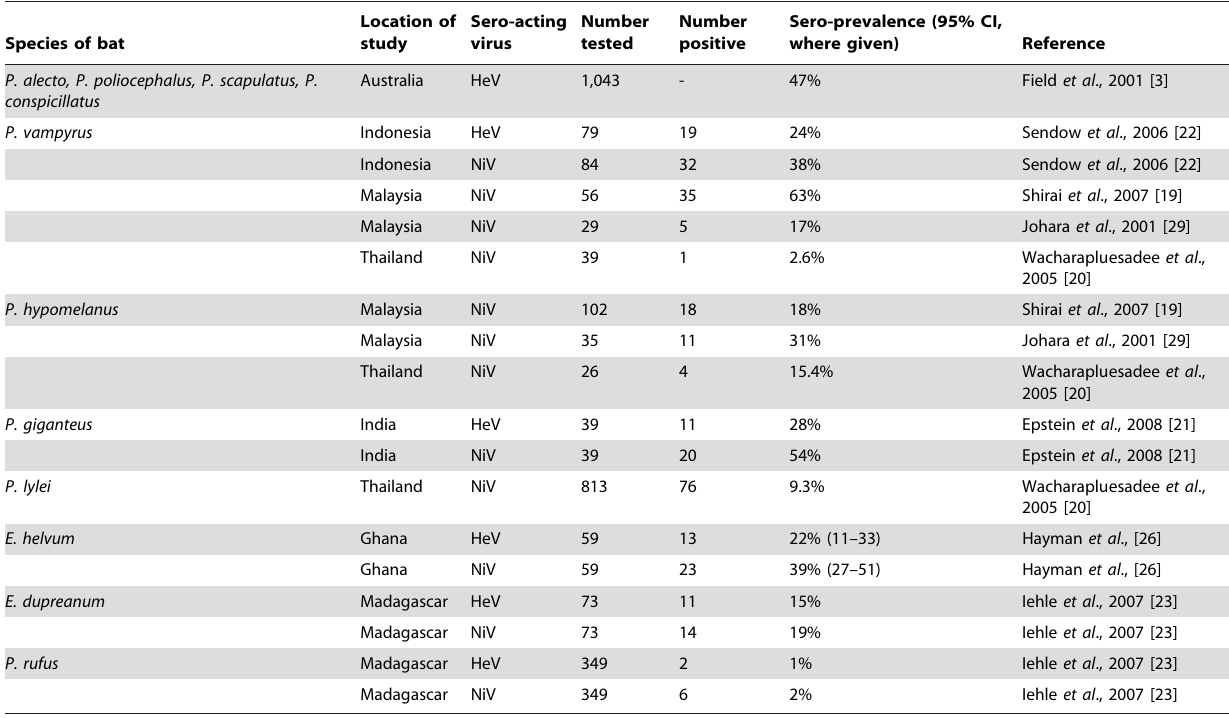
Table 1. Seroprevalence of henipaviruses (HeV and NiV) in fruit bats.